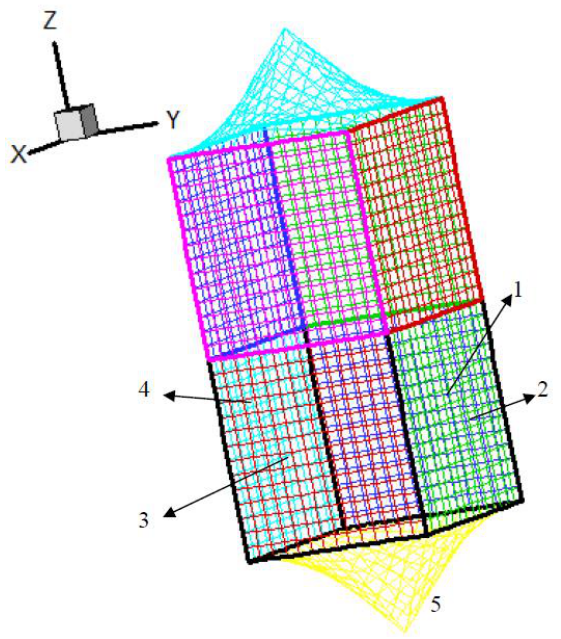
Figure 1. An arbitrary radiator in the half-space domain (Label 1–4: the square faces of the cubic, Label 5: the pyramid face).